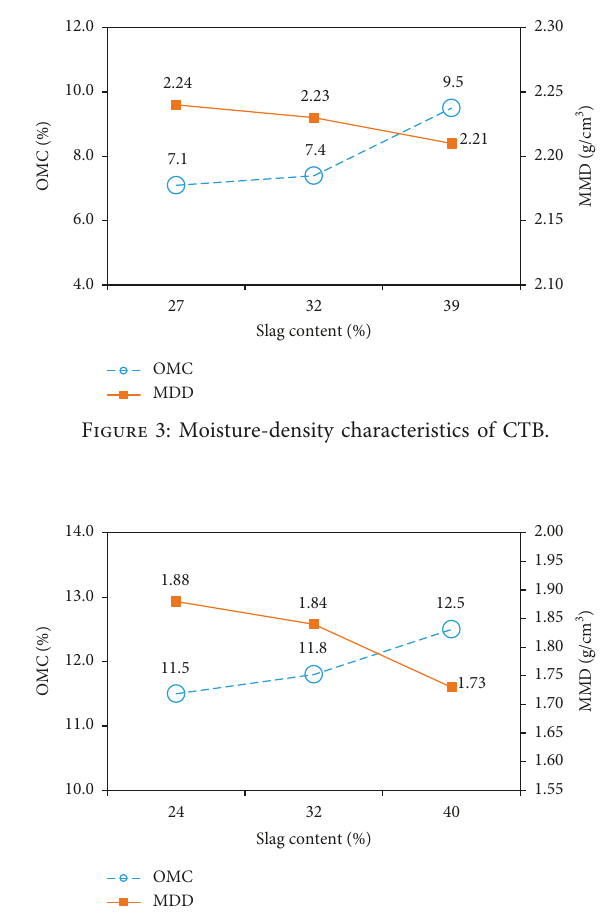
Figure 4: Moisture-density characteristics of